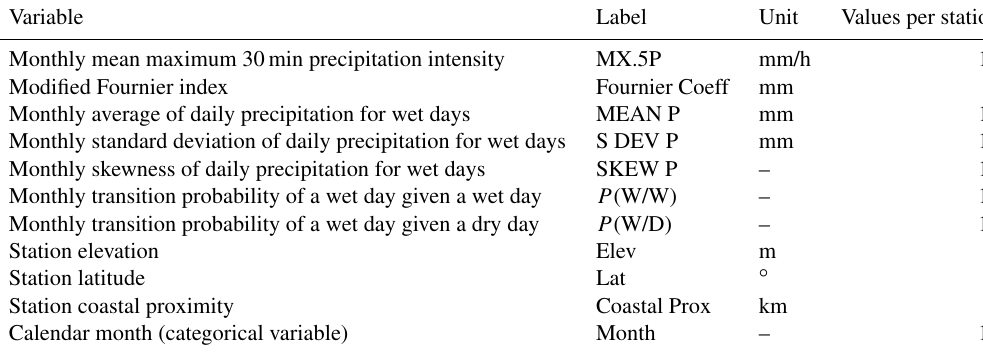
Table 3. The 11 predictor variables for the gradient-boosting regression model used to temporally downscale MX.5P from GHCN-Daily data. Units were changed to metric for the purposes of the downscaling